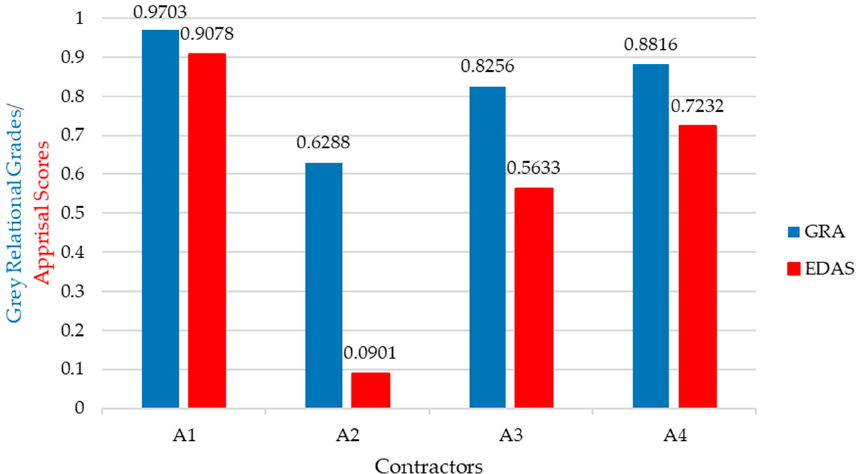
Figure 4. Ratings by the grey relational analysis (GRA) and evaluation based on distance from average solution (EDAS) based on grey SWARA-FUCOM weights.